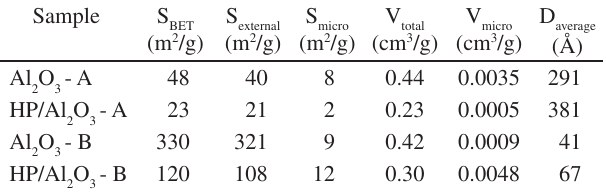
O - A based catalysts: a) Al 2 3